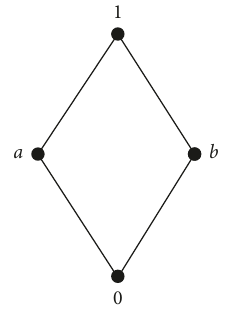
Figure 1: The order “ Table 1: The binary operation “ Table 2: The binary operation “